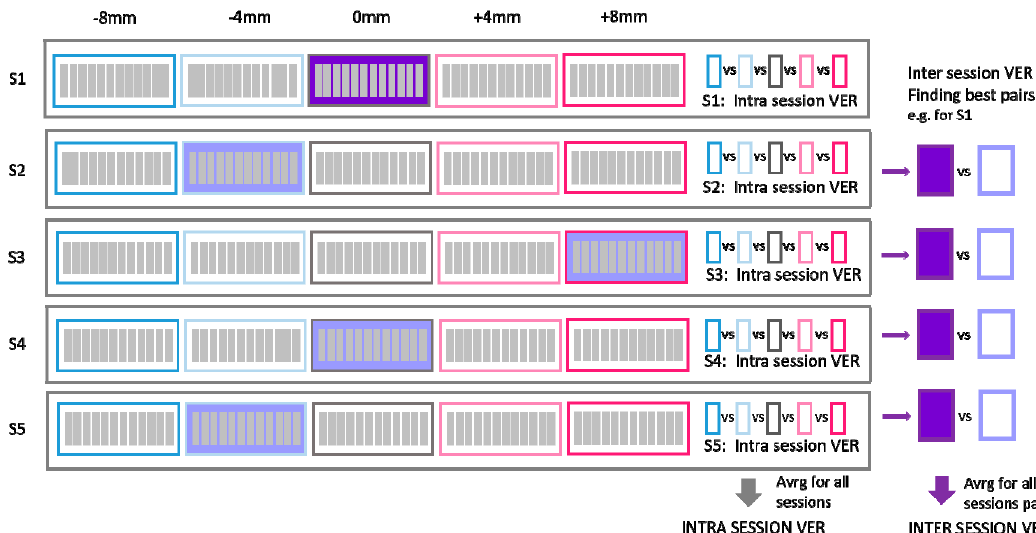
Figure 6. Summary of the composition of the datasets to analyze the possible influence of electrode repositioning: For each session (S1–S5) of each subject, data for 4 simulated displacements ( − 8 mm, − 4 mm, 4 mm, and 8 mm) were calculated interpolating data from neighboring electrodes. This new artificial data was used (1) to calculate similarity of extracted synergies between steps from the same session (intra-session VER) and (2) to calculate similarity of extracted synergies between steps from di ff erent sessions (inter-session VER). This was achieved by calculating and comparing similarities of synergies between all combinations of steps between two sessions to find the optimal step for each session related to the reference session (in the figure, we assumed S1 as the reference). This optimal step can represent a reconfiguration of the positioning corresponding to the most similar positioning with respect to S1. The same procedure was repeated considering each session as reference and calculating the average of all max similarities (inter-session VER).